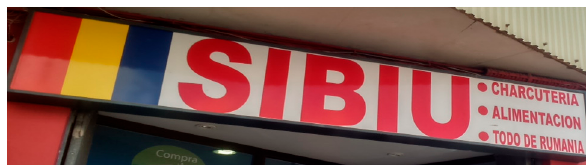
Figure 33. Almazora: English-Spanish sign on a language academy .